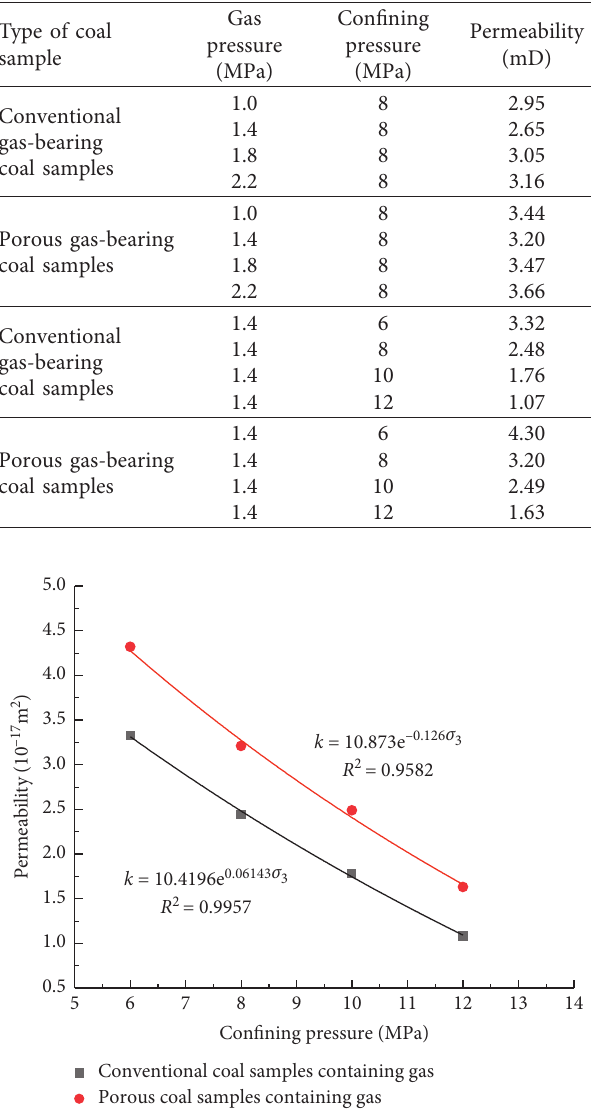
Table 1: Experimental results of seepage of porous and conven- tional gas-bearing coal